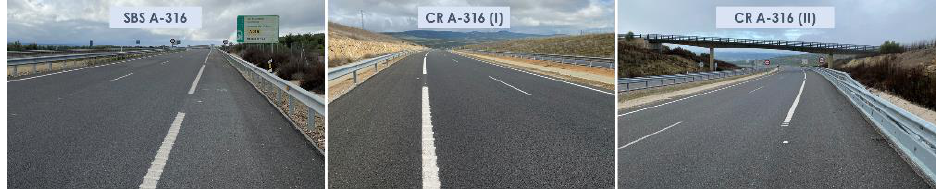
Figure 3. Aspects of the surface asphalt layers manufactured with SBS and crumb-rubber-modified binders on A-316 highway after 63 months of service life.